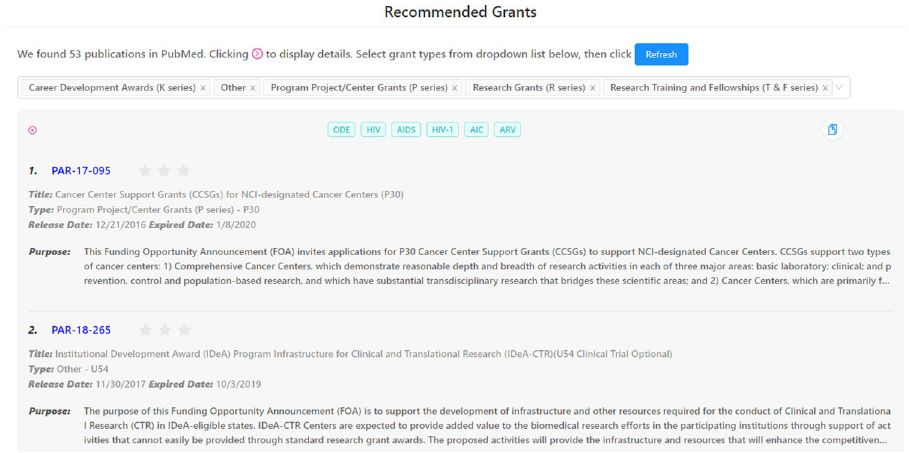
Fig 7. Service platform with evaluation collection.